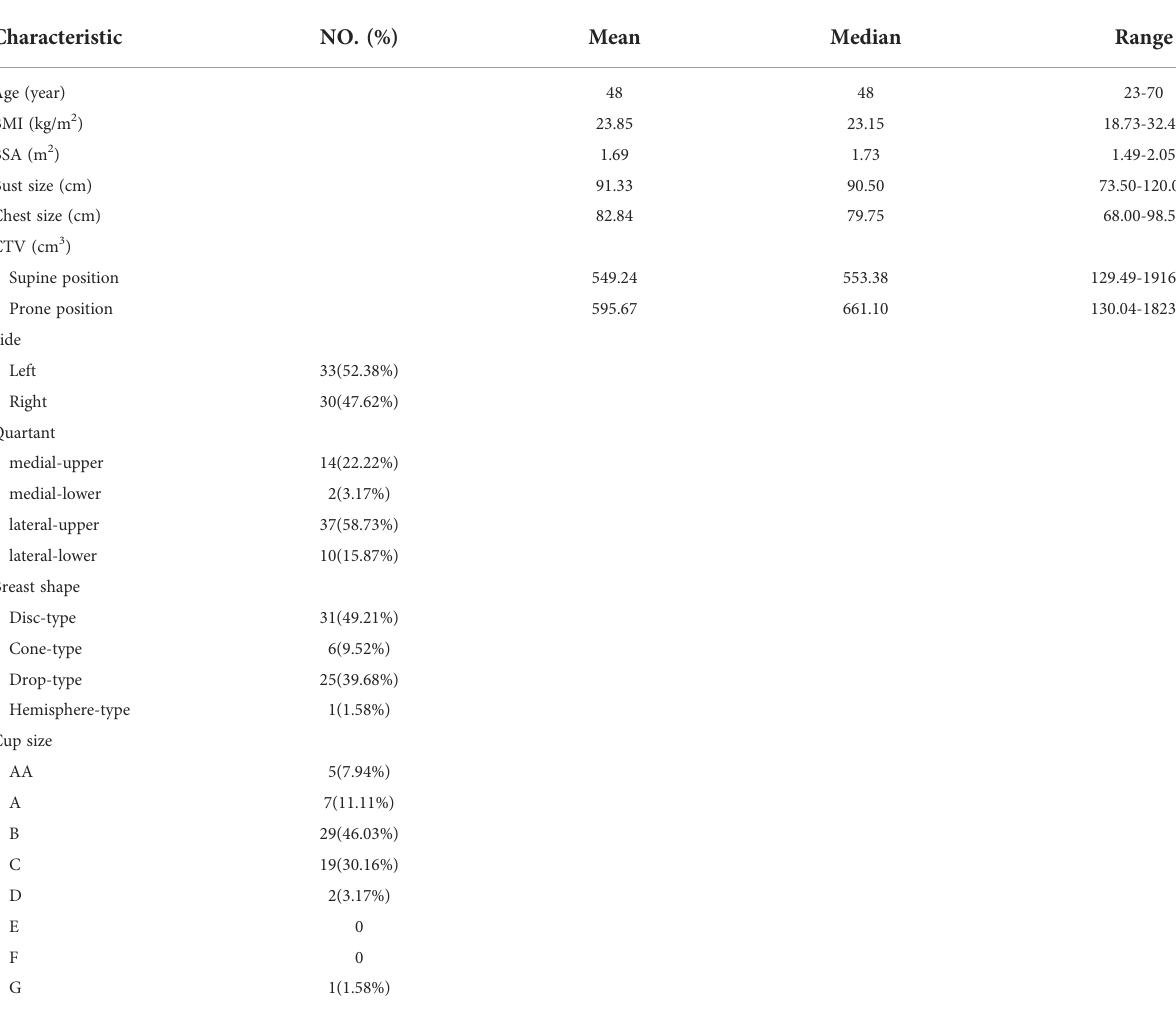
TABLE 1 Patient and tumor characteristics